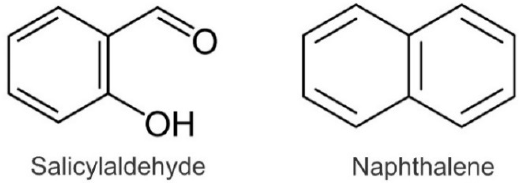
Figure 2. Molecules of salicylaldehyde and naphthalene.